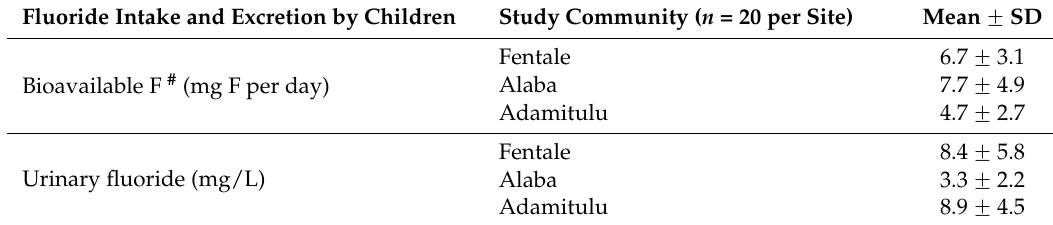
Table 3. Fluoride intake at 60% bioavailability and urinary fluoride concentration. Fluoride Intake and Excretion by Children Study Community ( n = 20 per